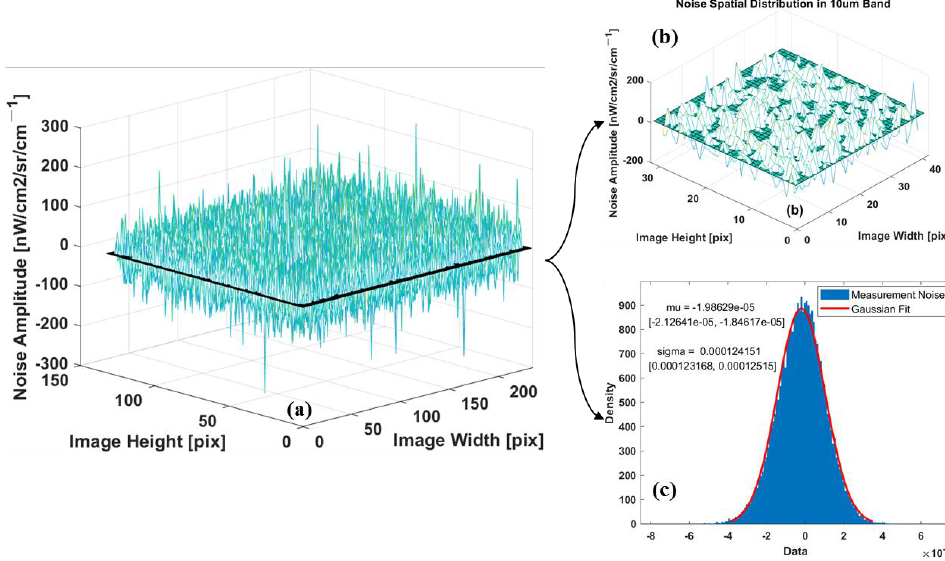
Figure 8. TIR hyperspectral imagery noise analysis: ( a ) the pixel-wise noise in the 10 µm band; ( b ) the noise for a small random window; ( c ) the magnitude distribution of all the pixels in the 10 µm band.